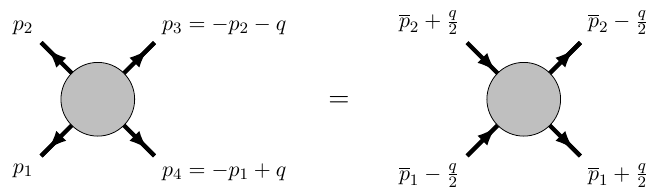
Figure 3. Depiction of the parameterization of external momenta useful for the soft